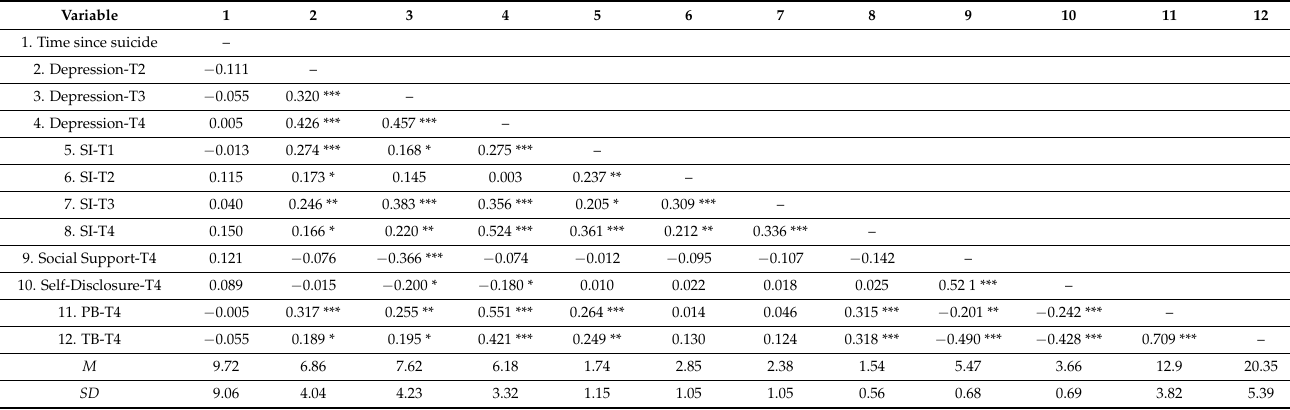
Table 1. Inter-correlations among the study variables ( N =